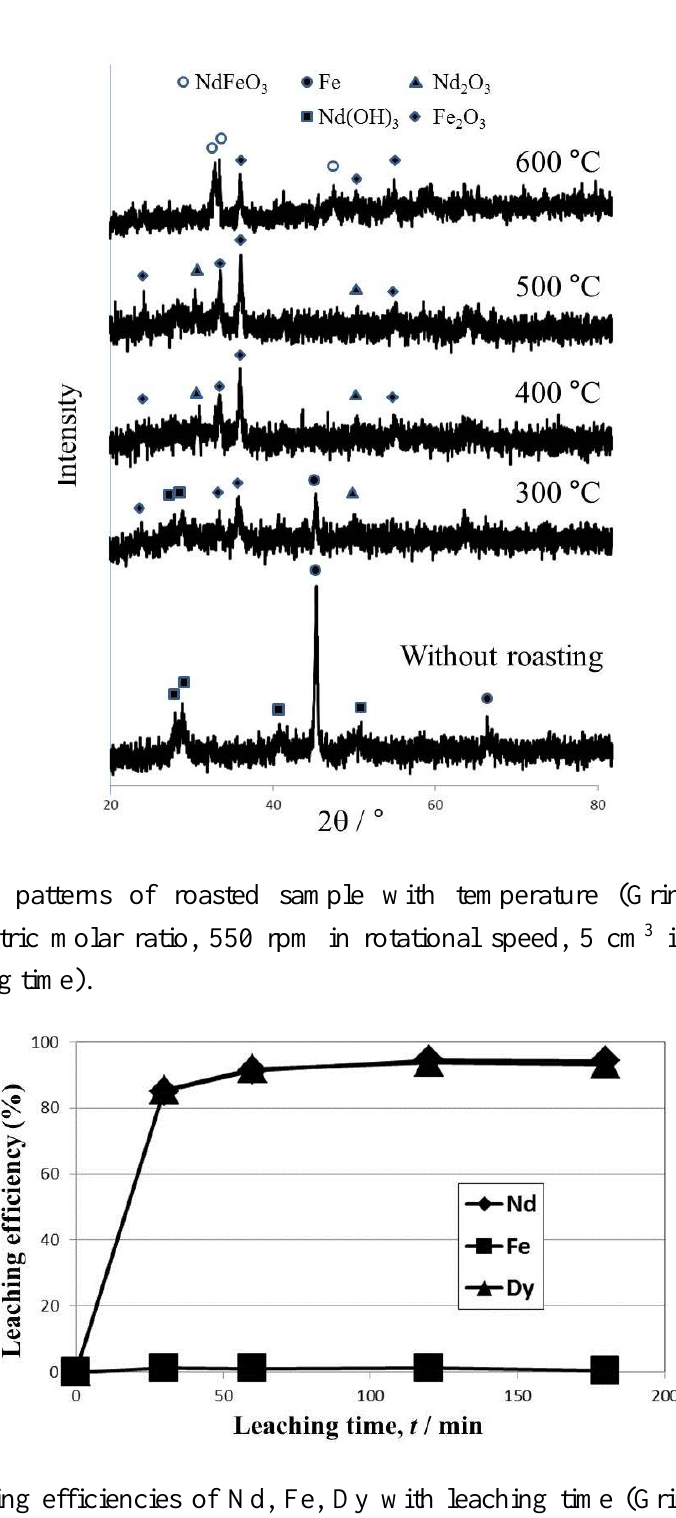
Figure 4. Leaching efficiencies of Nd, Fe, Dy with leaching time (Grinding conditions: 15 in stoichiometric molar ratio, 550 rpm in rotational speed, 5 cm 3 in water addition, 30 min in grinding time, roasting condition; 2 h at 400 °C, leaching conditions: 400 rpm, 1 kmol·m −3 acetic acid, 90